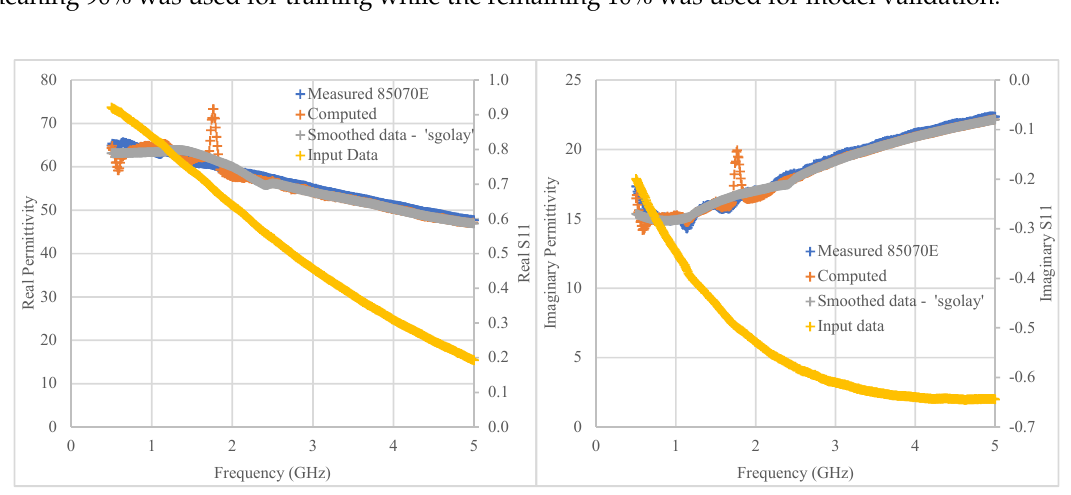
Figure 8. Plots showing the real and imaginary parts of the permittivity of 30 mL of 0.1 M NaCl + 20 g glucose from 0.5 to 5 GHz. The values measured with the slim-form probe appear in blue, the corresponding ANN-predicted values are marked in orange while the grey data points show the corresponding predicted values following smoothing with Sgolay. The corresponding S11 measurements are shown in yellow for comparison. Calibration point: reference plane A (probe tip). Note: The computed (ANN predicted) values for both real and imaginary parts of the permittivity are a function of both parts of S11 at each